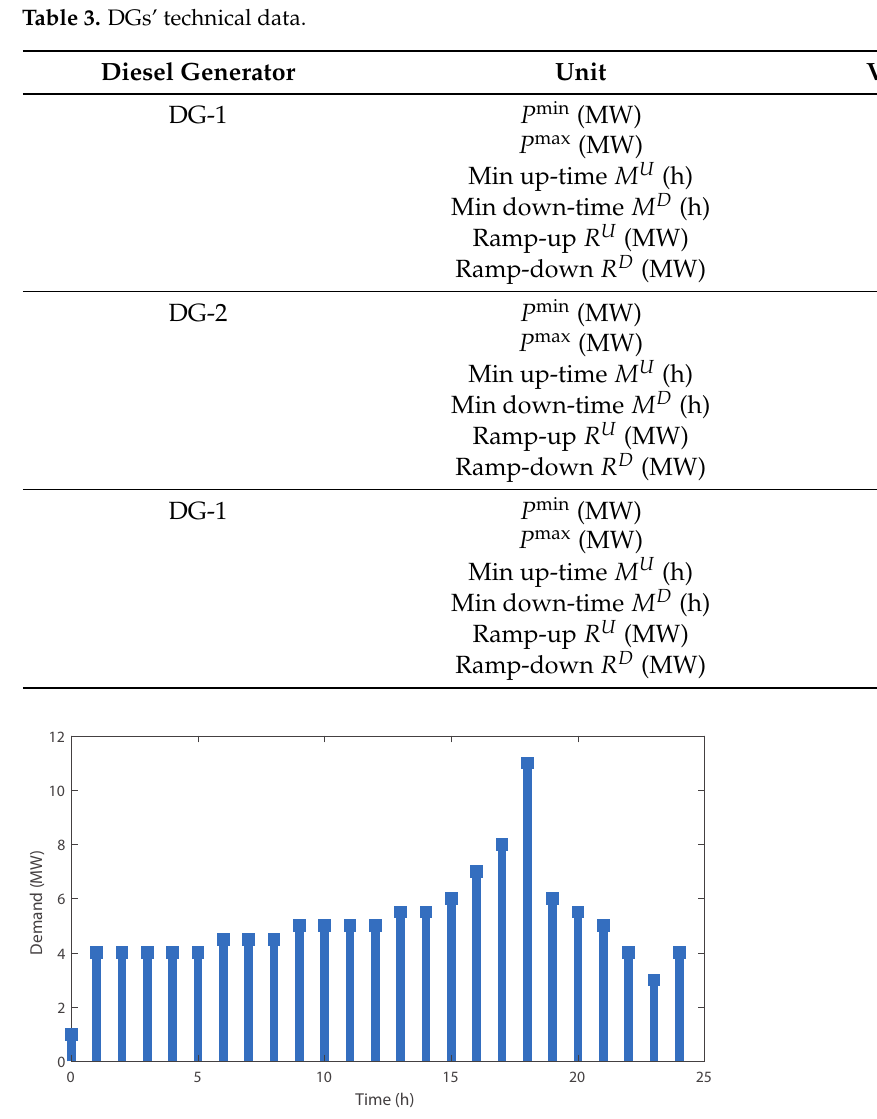
Figure 4. Electricity